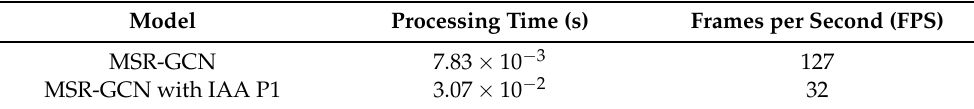
Table 4. Processing time and frames per second (FPS) required to predict 30 frames from 12 frames of